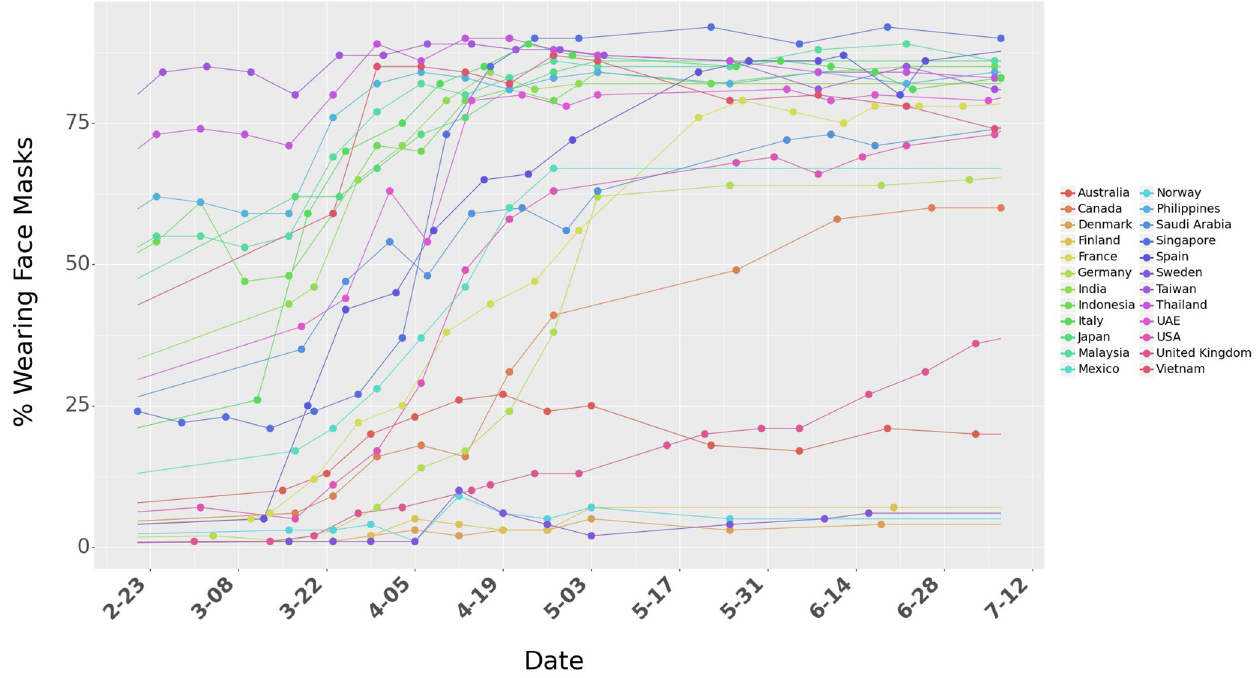
Fig 1. Percentage of people who say they are wearing a face mask in public